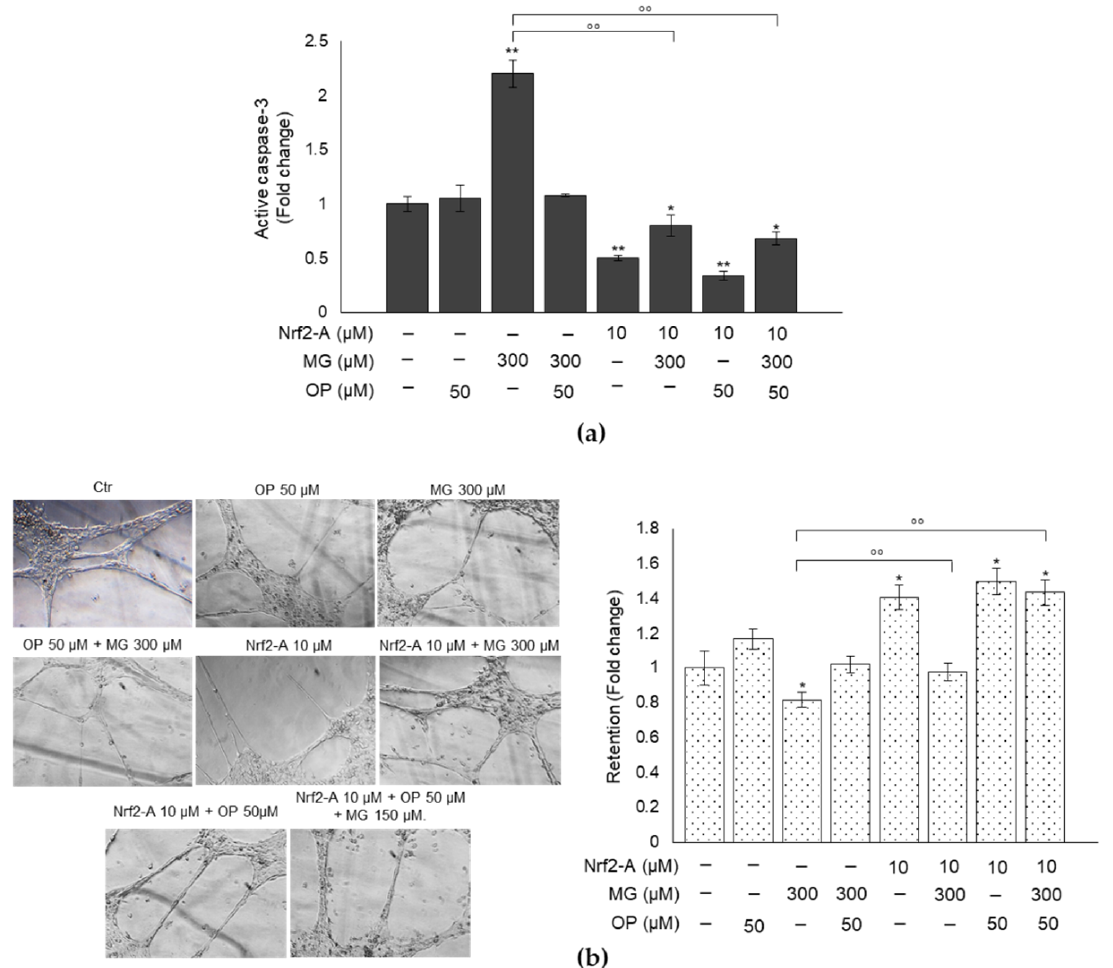
Figure 9. OP prevention of MG-induced responses through Nrf2/Glo1 axis in DPSCs. ( a ) Nrf2 activator (Nrf2-A) reduced MG-induced caspase-3 activation. ( b ) Representative images of co-cultures of DPSCs and HUVECs exposed to MG in the presence of OP and/or Nrf2-A show that Nrf2 activation determined a significant rescue of tubule stabilization from DPSCs, compared with MG-challenged cells. Histograms indicate the means ± SD of three different cultures, each of which was tested in triplicate. * p < 0.05, ** p < 0.01 versus unexposed cells; ◦◦ p < 0.05, versus MG-treated cells.